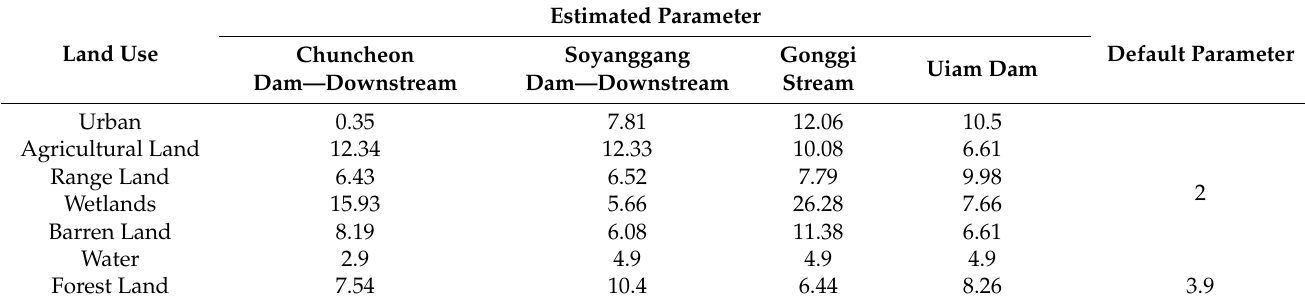
Table 3. Default and estimated parameters (LZSN) for each land use in